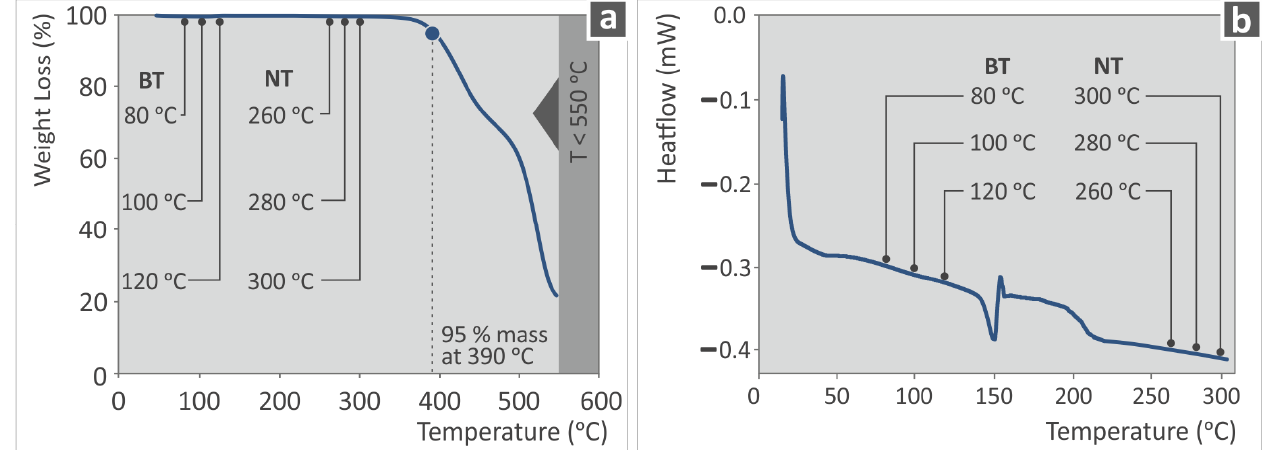
Figure 2. For the PC grade studied here, ( a ) weight loss vs. temperature graph (°C) (TGA), ( b ) endo graph (DSC).